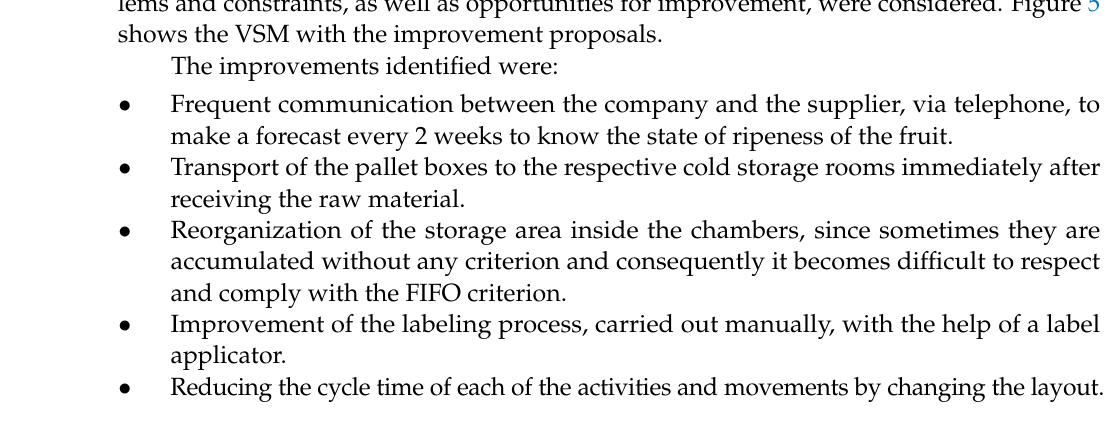
Figure 4. Current VSM of production.